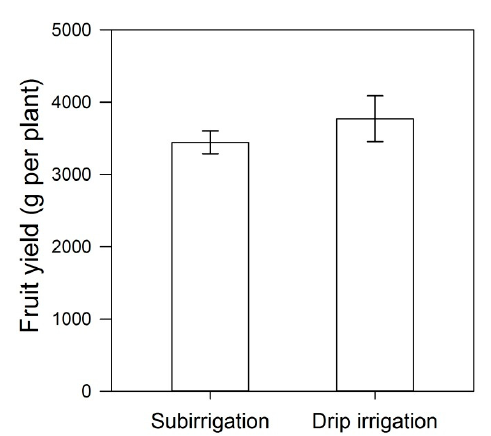
Figure 1. Fresh fruit yield of tomato ( Solanum lycopersicum L.) plants grown in two irrigation systems. Means were significantly different according to ANOVA (p ≤ 0.018).